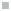
NLC and eM in the presence of DFL and in different chloride conditions.(A) V1/2 value obtained with OHCs from two-state Boltzmann fits of the NLC (○ at low & ● at high intracellular chloride) and the eM (◻ at low & ■ at high intracellular chloride), plotted against DFL concentration. (B) The difference V1/2(NLC)—V1/2(eM) shows decoupling between charge transfer and electromotility as [DFL] increases. The t-test is conducted between the values obtained without DFL versus with DFL * p<0.01; ** p<0.001. (C) Inhibition of the NLC and (D) of the eM by DFL. The dotted line is the resulting fit of the data by a Hill equation (140mM Cl: nH = -0.66, IC50 = 331 μM; 5mM Cl-: nH = -1.12, IC50 = 98 μM), The resulting eM is only inhibited at concentrations above 0.5 mM in low chloride conditions. The value for eM at 1mM DFL at low chloride concentration was obtained from direct measurement of cell length at hyperpolarized and depolarized voltages (star). For all plots, the data points represent the average and the error bar is the standard deviation for n≥3 cells per condition.